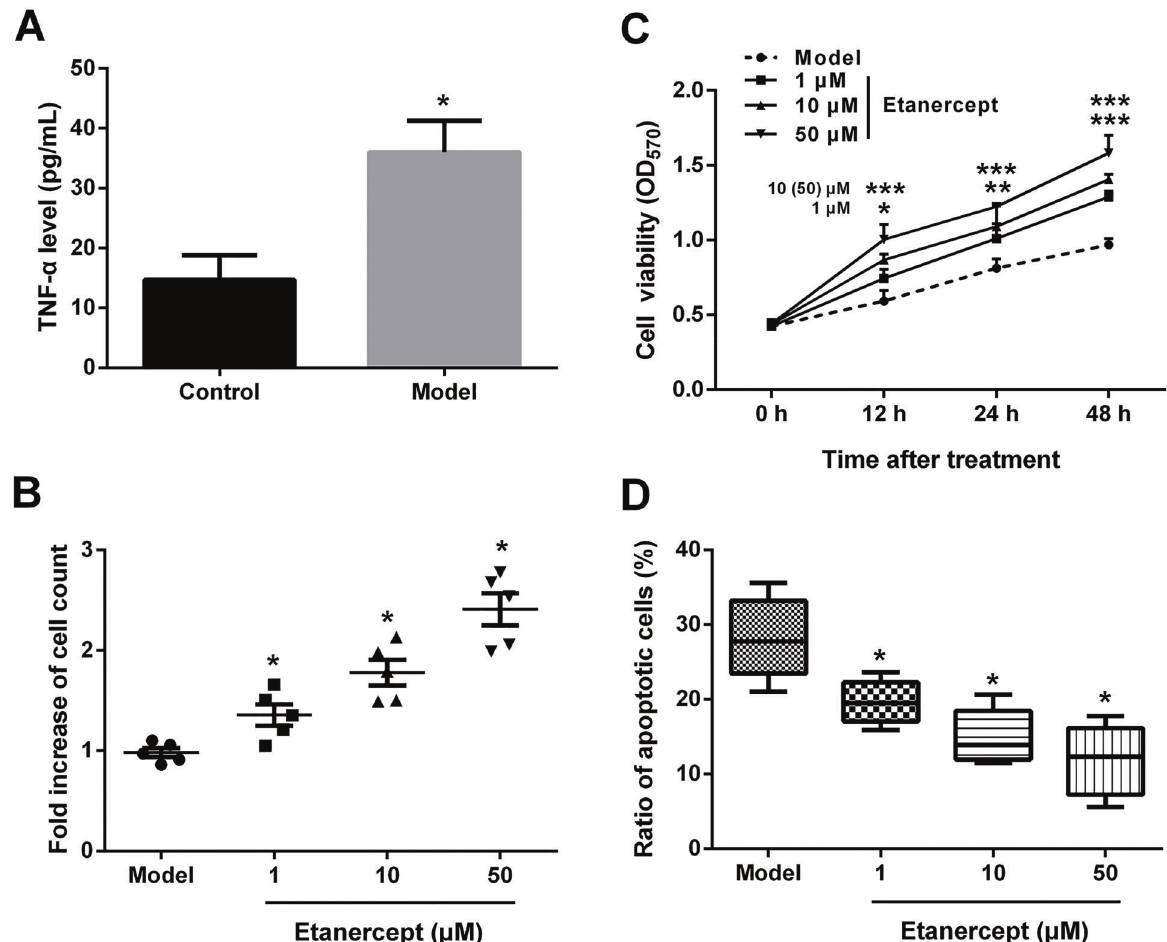
Figure 1. Etanercept promoted cell proliferation but inhibited cell apoptosis in endothelin-induced cardiomyocyte hypertrophy. Cardiomyocytes treated with endothelin alone acted as the model, and non-treated cardiomyocytes acted as the control. A , Tumor necrosis factor- a (TNF- a ) level assessed by ELISA. B , Cell counts assessed by trypan blue staining. C , Cell viability assessed by 3-(4,5- dimethylthiazol-2-yl)-2,5-diphenyltetrazolium bromide (MTT) assay. D , Ratio of apoptotic cells assessed by TUNEL assay. Data in A – C are reported as means ± SD. Data in D are reported as medians and error bars indicate minimum and maximum values. *P o 0.05 compared with control in A ; *P o 0.05, **P o 0.01 or ***P o 0.001 compared with model